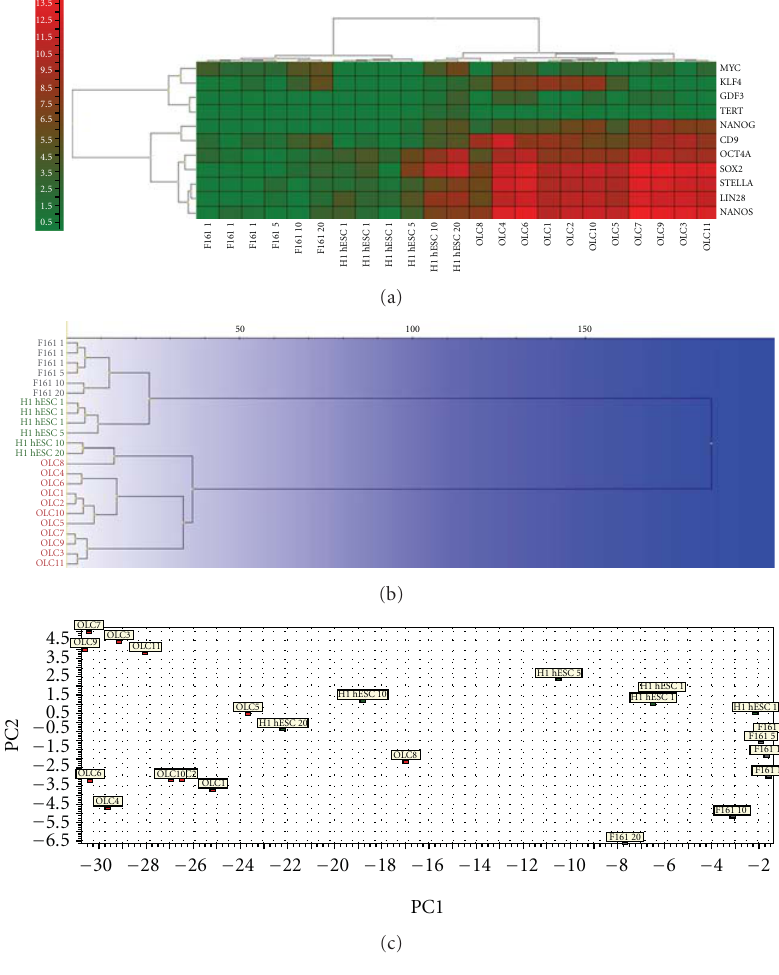
Figure 9: Single-oocyte-like cell gene expression analyses in comparison with human embryonic stem cells and human fibroblasts. (a) Heatmap clustering. (b) Hierarchical clustering (Ward’s Algorithm, Euclidean Distance Measure). (c). Principal component analysis (PCA). Legend : OLC: single oocyte-like cells, H1 hESC: human embryonic stem cells (H1 cell line), F161: human fibroblasts (F161 cell line), 1: single cell, 5: group of five cells, 10: group of ten cells, and 20: group of twenty